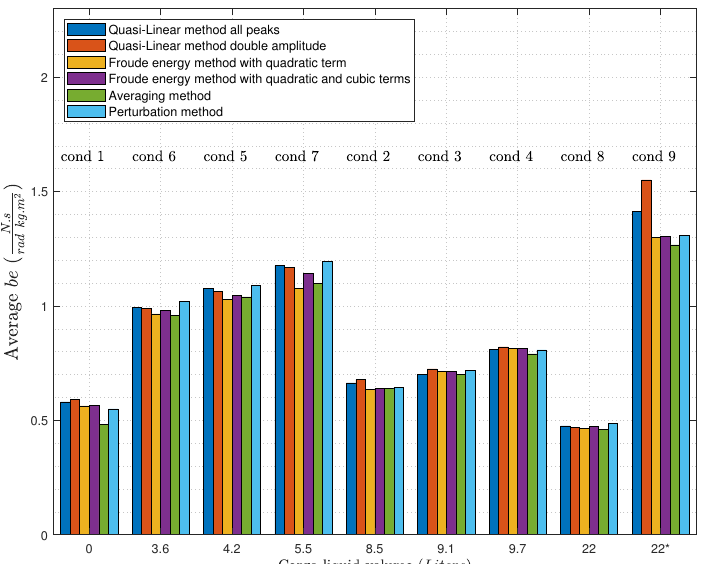
Figure 12. Average equivalent damping coefficient b e and as a function of the liquid cargo volume for the different test conditions. Note that conditions 8 and 9 have the same cargo volume but different draft, see Tables 3 and